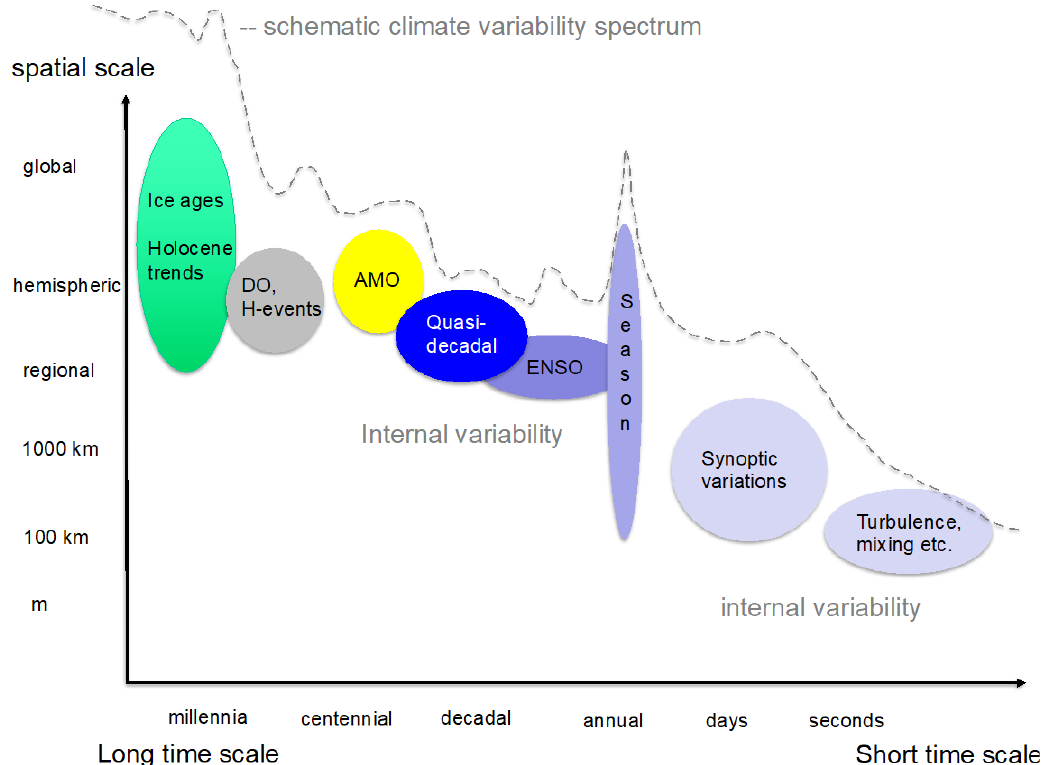
Figure 4. Temporal–spatial scales. Any climate (or Earth system question) has a typical spatial scale, e.g., focusing on a geographic region or processes on specific scales, such as turbulence. Schematic diagram of the spatiotemporal scales considered. DO: Dansgaard–Oeschger, H: Heinrich events; AMO: Atlantic multidecadal oscillation; PDO: Pacific decadal oscillation; ENSO: El Niño–southern oscillation. The annual and astronomical cycles are externally driven and have quasiglobal impact. The dashed line shows a schematic power spectrum with more variability on long time scales. The temporal scale is quite often related to the spatial scale: changes on longer timescales are more global than regional. For example, turbulence has a small spatial and temporal scale compared to synoptic weather systems. This relation is a general tendency unless external force is considered. Then, a short-term event like a volcano may have a global effect.